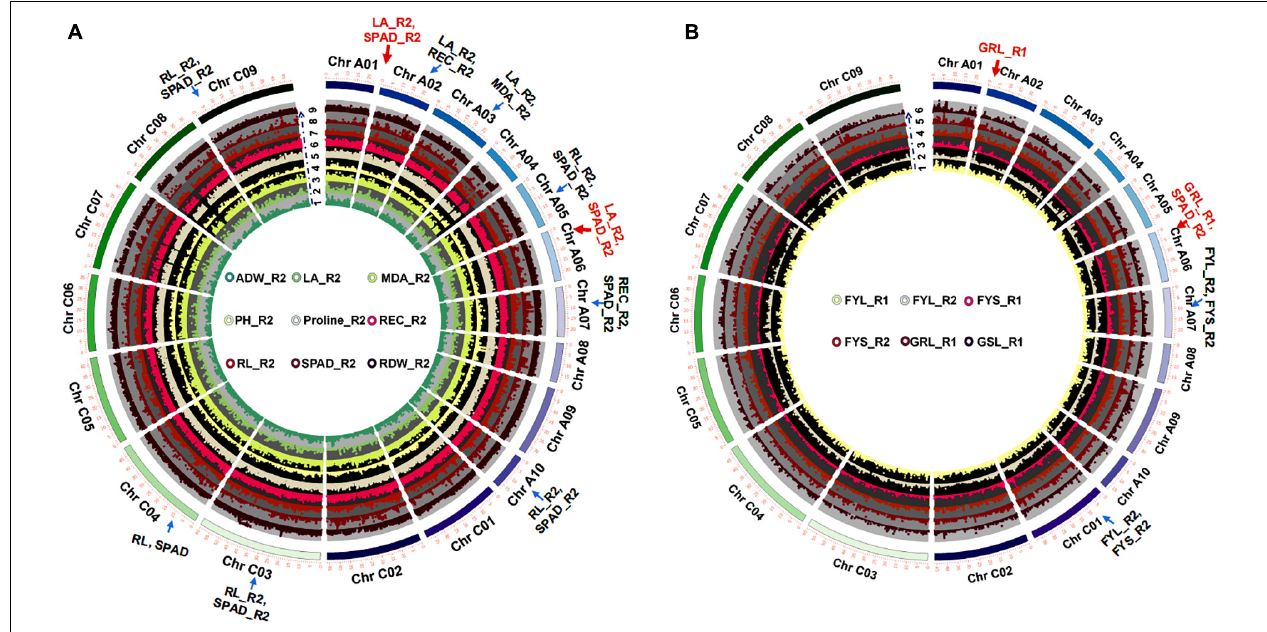
FIGURE 2 | GWAS of STCs at germination and seedling stages. (A) Circle Manhattan plots with the co-localized SNPs of multiple traits at the seedling stage ( P -value ≤ 1e-2; arrows represent sites of co-located SNPs). 1: ADW_R2, the ratio of aboveground dry weight between normal condition and 215 mM NaCl; 2: LA_R2, the ratio of leaf area between normal condition and 215 mM NaCl; 3: MDA_R2, the ratio of MDA content between normal condition and 215 mM NaCl; 4: PH_R2, the ratio of plant height between normal condition and 215 mM NaCl; 5: Proline_R2, the ratio of proline content between normal condition and 215 mM NaCl; 6: REC_R2, the ratio of relative electrolyte leakage between normal condition and 215 mM NaCl; 7: RL_R2, the ratio of root length between normal condition and 215 mM NaCl; 8: SPAD_R2, the ratio of chlorophyll content between normal condition and 215 mM NaCl; 9: RDW_R2, the ratio of root dry weight between normal condition and 215 mM NaCl. (B) Circle Manhattan plots with the co-localized SNPs of multiple traits at the germination stage ( P- value ≤ 1e-2; arrows represent sites of co-located SNPs). 1: FYL_R1, the ratio of germination rate between normal condition and 150 mM NaCl; 2: FYL_R2, the ratio of germination rate between normal condition and 215 mM NaCl; 3: FYS_R1, the ratio of germination potential between normal condition and 150 mM NaCl; 4: FYS_R2, the ratio of germination potential between normal condition and 215 mM NaCl; 5: SL_R1, the ratio of shoot length between normal condition and 150 mM NaCl; and 6: RL_T1, the ratio of root length between normal condition and 150 mM